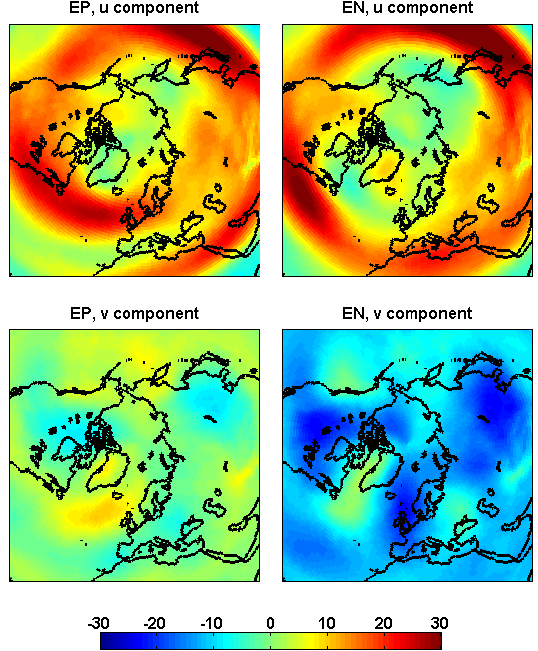
Fig. 10: The mean zonal and meridional components of winds computed using ERA- Fig. 10. The mean zonal and meridional components of winds com- Interim reanalysis data during the EN and EP phases. puted using ERA-Interim reanalysis data during the EN and EP phases.